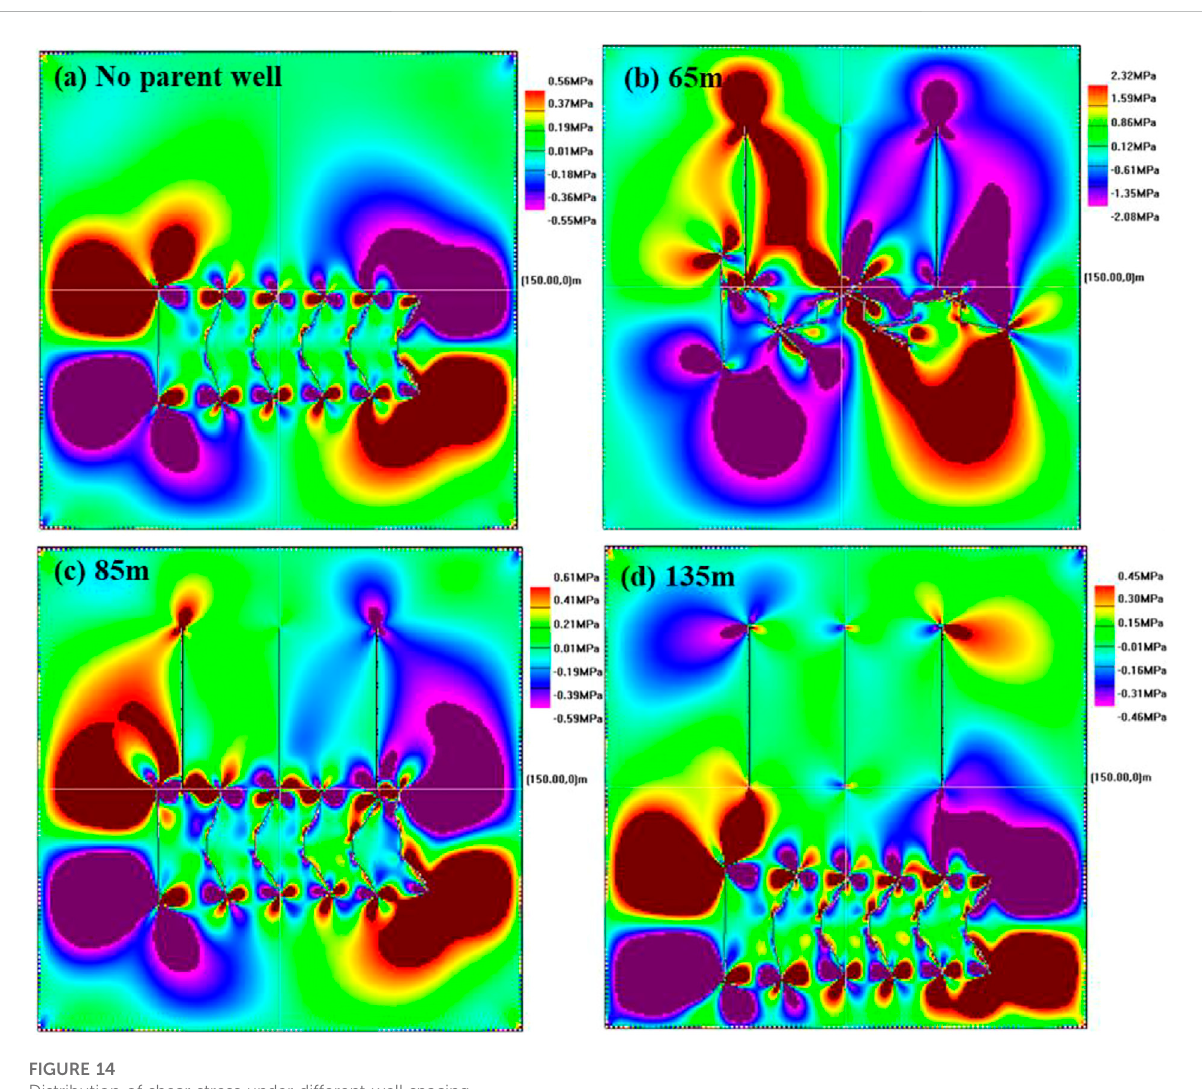
FIGURE 14 Distribution of shear stress under different well